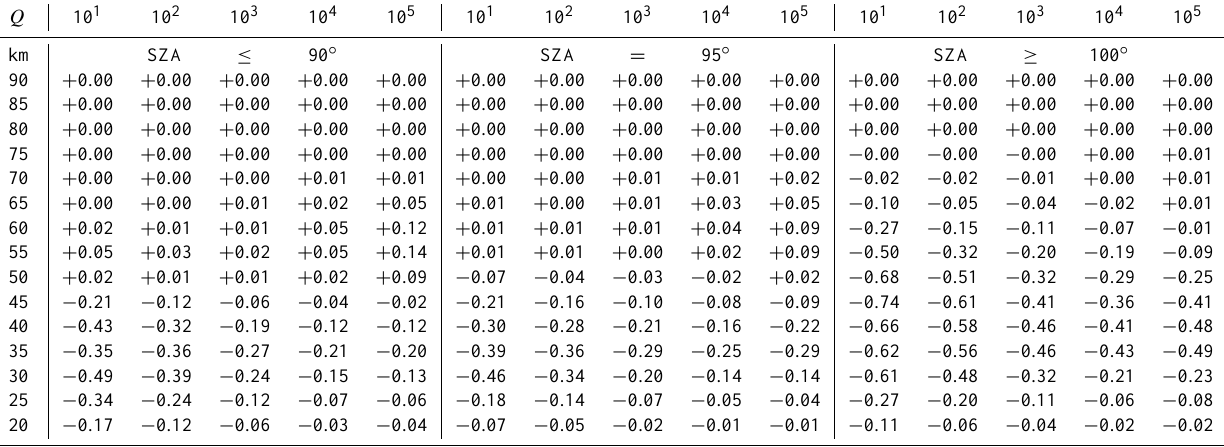
/Q for January NH. 2